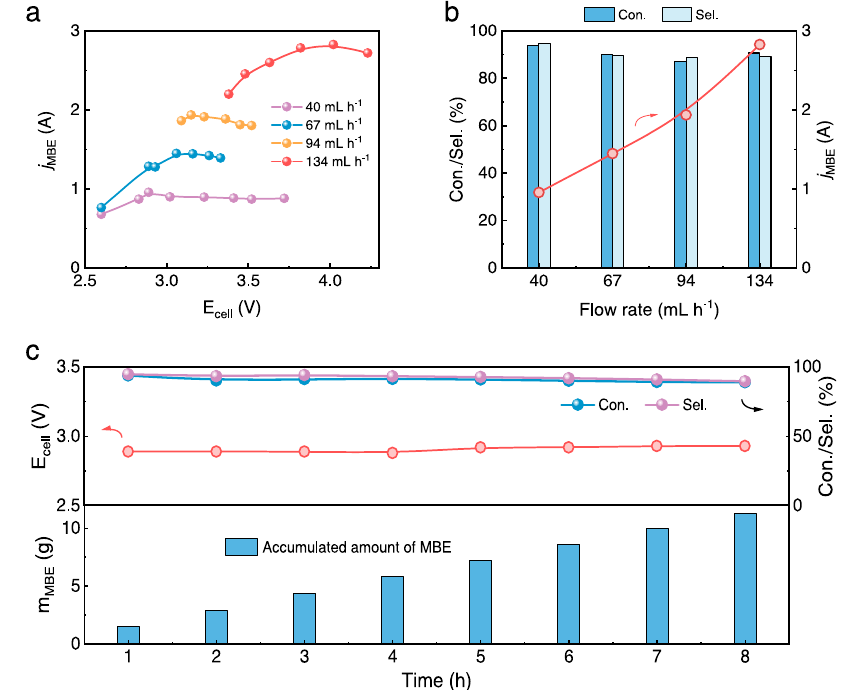
Fig. 4 | Electrocatalytic semi-hydrogenation performance of MBY on the Cu NAsina5×5cm 2 fl owelectrolyser.a PartialcurrentdensityofMBEatvariouscell voltages and electrolyte fl ow rates. b Maximum partial current density of MBE, corresponding MBY single-pass conversion and MBE selectivity at different